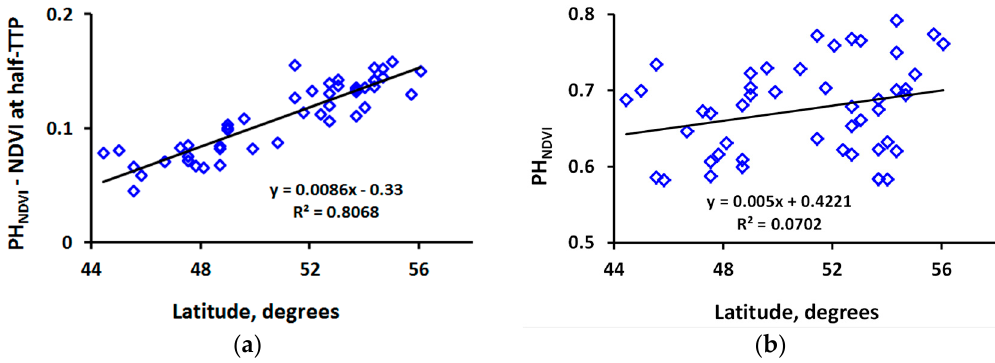
Figure 8. Scatterplot for: PH NDVI minus NDVI at half-TTP (NAHT) as a function of latitude ( a ); and PH NDVI as a function of latitude ( b ). Both are fitted with linear trend line yielding strong correspondence for the former (R 2 = 0.81), but no clear correspondence for the latter (R 2 = 0.07).